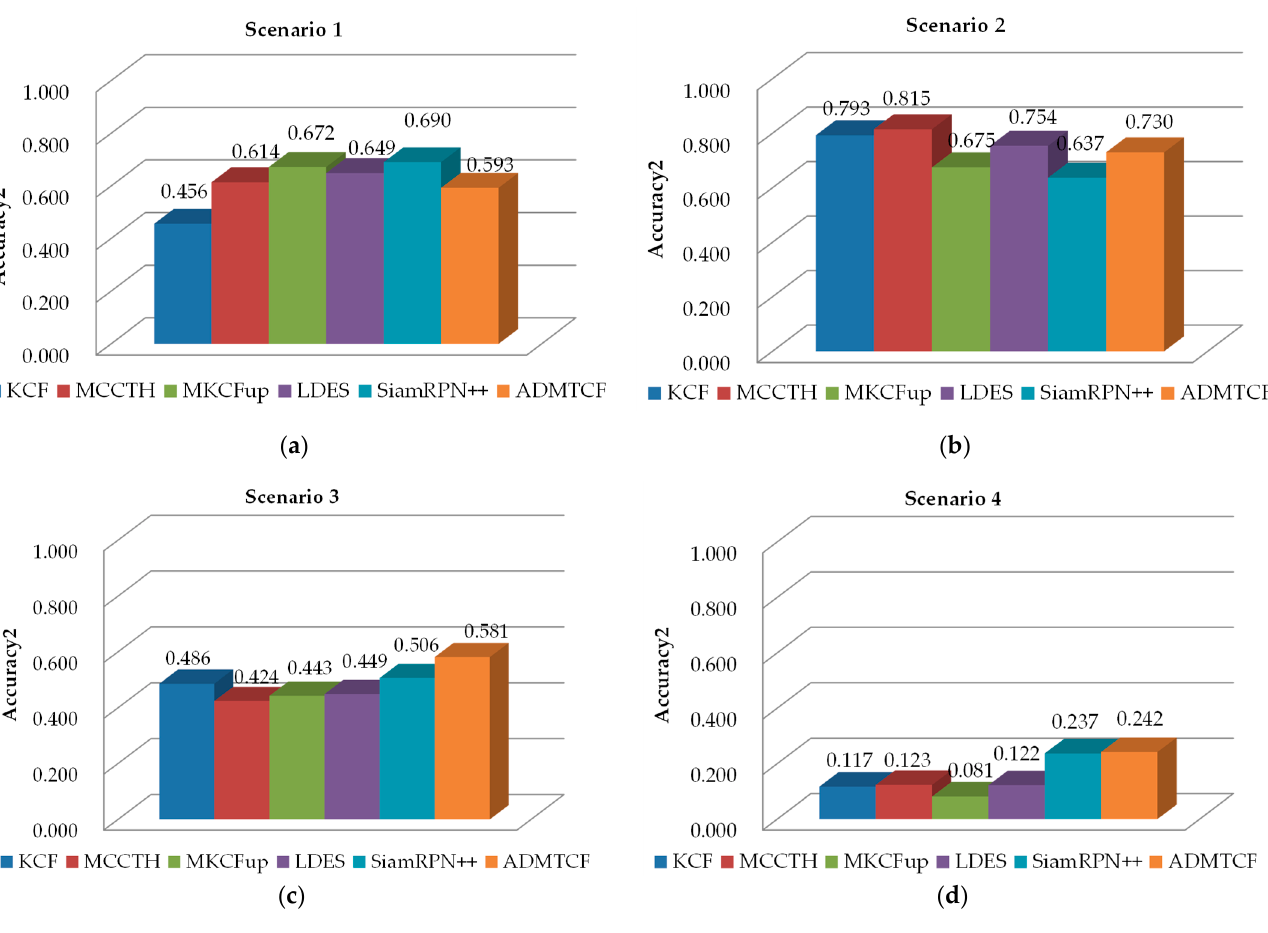
Figure 14. Tracking accuracy using Metrics-2: ( a ) scenario 1; ( b ) scenario 2; ( c ) scenario 3; ( d ) scenario 4.